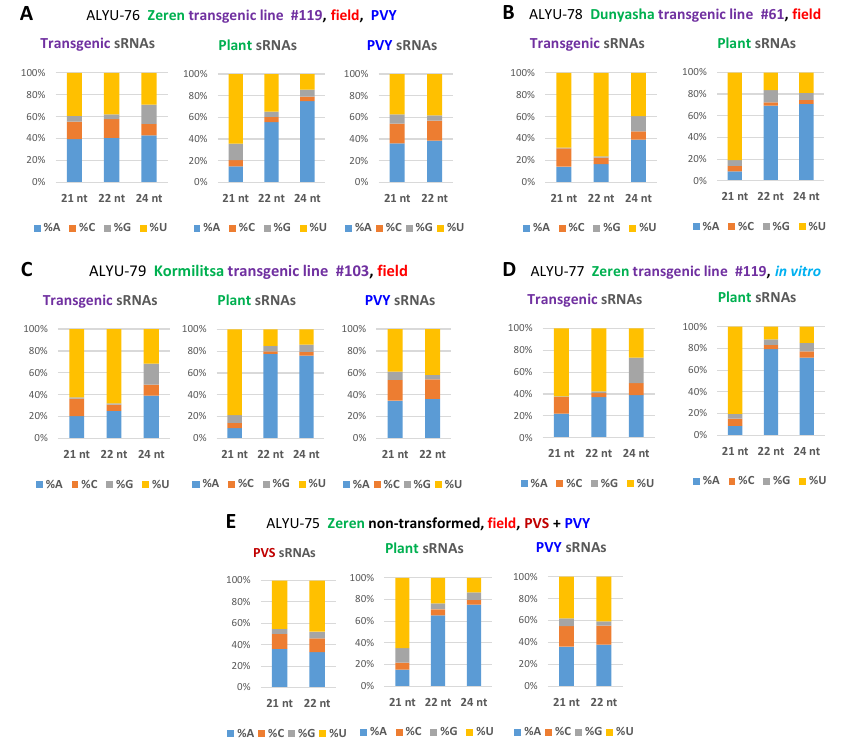
Figure 3. The 5 ′ -nucleotide profiles of major size classes of transgenic, plant, and viral sRNAs. Redundant 20–25 nt sRNA reads from leaf samples of the transgenic lines of cultivars Zeren (line #119: field plant ALYU-76 and in vitro plant ALYU-77), Dunyasha (line #61: field plant ALYU-78), and Kormilitsa (line #103: field plant ALYU-79) and from a non-transformed Zeren plant (field plant ALYU-75) were mapped with zero mismatches to reference sequences of the transgene expression cassette, the S. tuberosum genome, and the reconstructed genomes of viruses (PVS and/or PVY) present in some of the plants (Datasets S1B); and the mapped sRNAs were sorted by size and 5 ′ -terminal nucleotide identity (5 ′ A, 5 ′ C, 5 ′ G, and 5 ′ U) and counted (Dataset S2C). The frequencies of each 5 ′ -nucleotide (in % of total) for each major size-class are plotted as bar graphs and color-coded. Panels show the resulting 5´-nucleotide profiles for the plants ALYU-76 ( A ), ALYU-78 ( B ), ALYU-79 ( C ), ALYU-77 ( D ) and ALYU-76 ( E ).